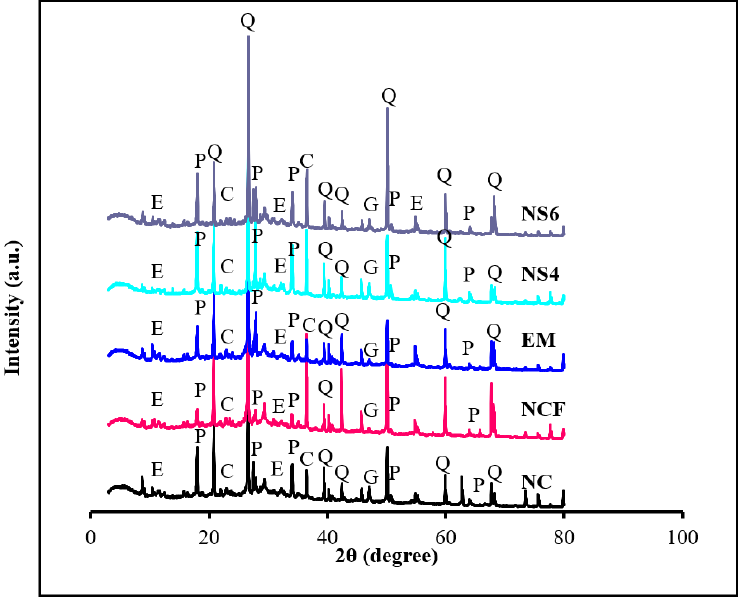
Figure 13. XRD patterns of the designed mixes at 28 days (Q: quartz; C: calcite; E: ettringite; P: port- landite; G: gypsum). P: portlandite; G: